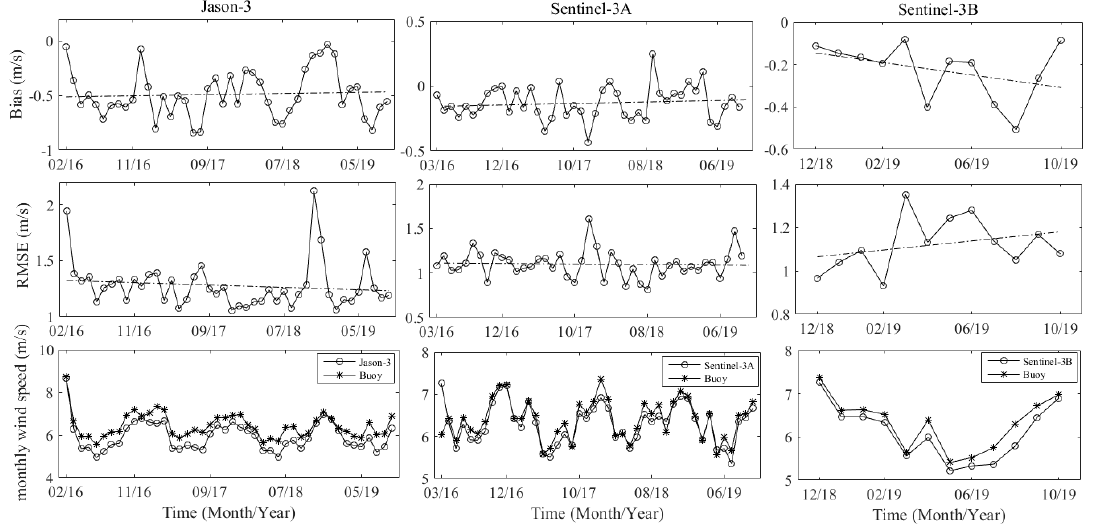
Figure 4. Dependence of statistical parameters of WS differences between the Jason-3, Sentinel-3A, Sentinel-3B altimeters and the moored buoys on the altimeter-derived WS.